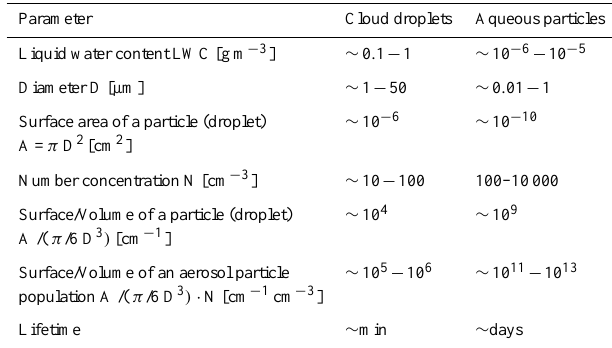
Table 1. Summary of parameters that characterize the aqueous phase of cloud droplets and aqueous particles (RH <